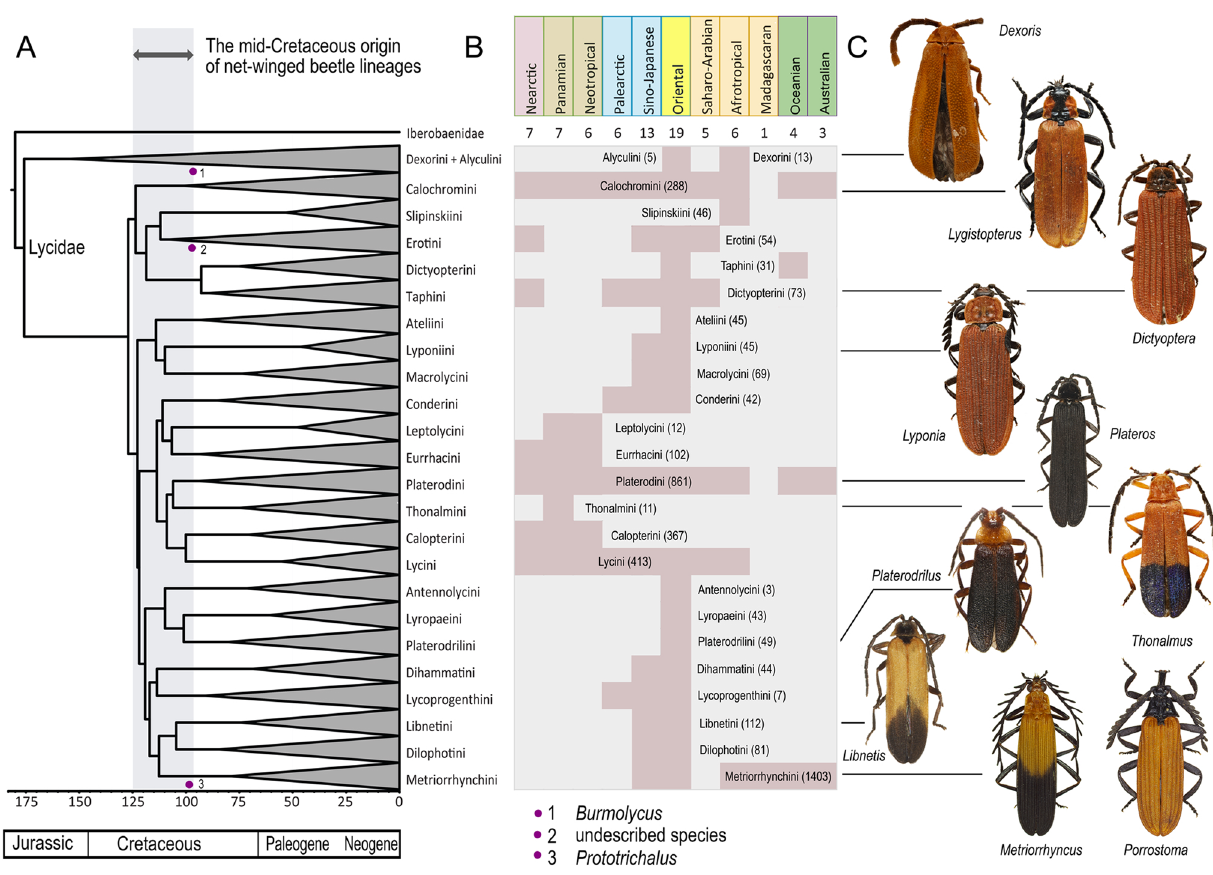
Figure 6. ( A ) The simplified dated tree of Lycidae, the red dots show the position of available fossils. ( B ) The distribution of lycid tribes with the number of described species for each tribe. ( C ) The examples of lycid general appearance. The full resolution tree is available in Fig. S917. All photographs and drawings by authors listed under the title of this